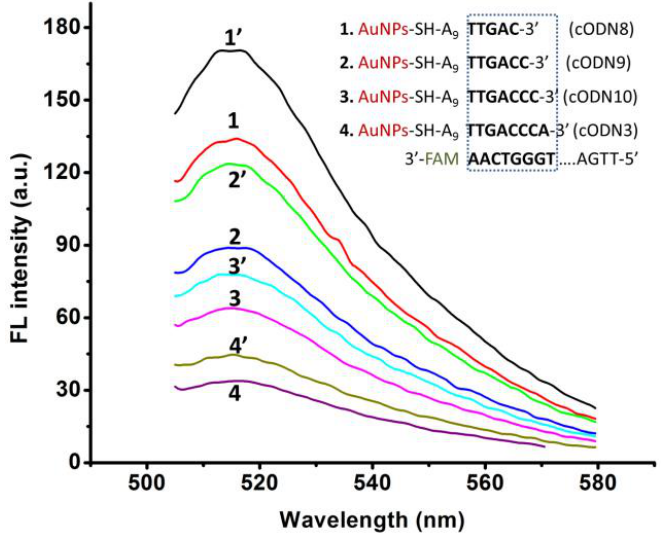
Figure 4. Effect of different hybridization length on the FRET efficiency of Apt-AuNPs and the fluorescence recovery of it in the presence of 60 nM rHuEPO-α. Curves 1 (1′), 2 (2′), 3 (3′) and 4 (4′) represent the fluorescence intensity of the formed Apt-AuNPs before and after binding with rHuEPO-α (60 nM),